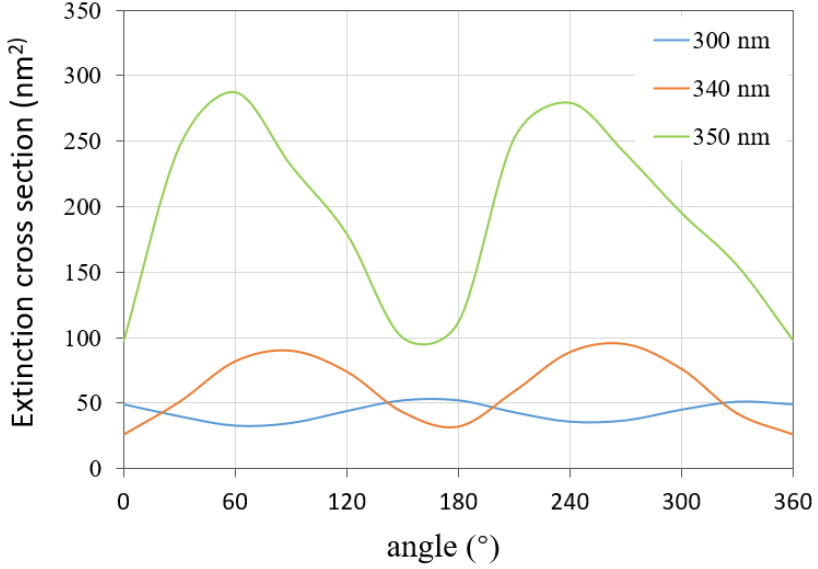
Figure 6. ECSs of the nanosphere array with the incident angle varying from 0 ◦ to 360 ◦ for different wavelengths.